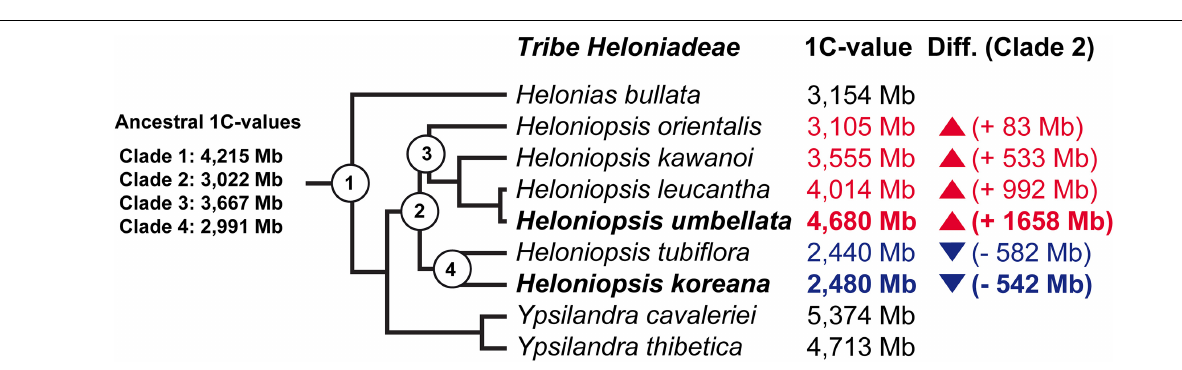
FIGURE 2 | Summary of the ancestral genome size reconstruction in tribe Heloniadeae. Branch tips include the extant 1C-values taken from Pellicer et al. (2014) with the increase (red) or reduction (blue) in genome size indicated based on the 1C-value reconstructed for the most recent common ancestor of the genus (i.e., Clade